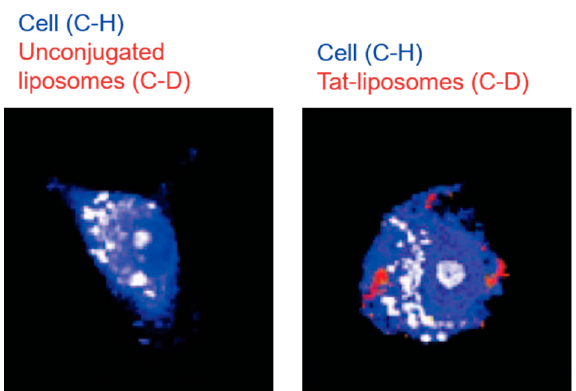
Figure 5. Uptake of deuterated liposomes to MCF-7 cells after 6 h of incubation. C–H stretching shown in blue and C–D stretching shown in red. There are no unlabeled liposomes inside the cell after 6 h but the TAT-liposomes are visible in the cytoplasm. Reproduced with permission from [85], Copyright American Chemical Society, 2008.